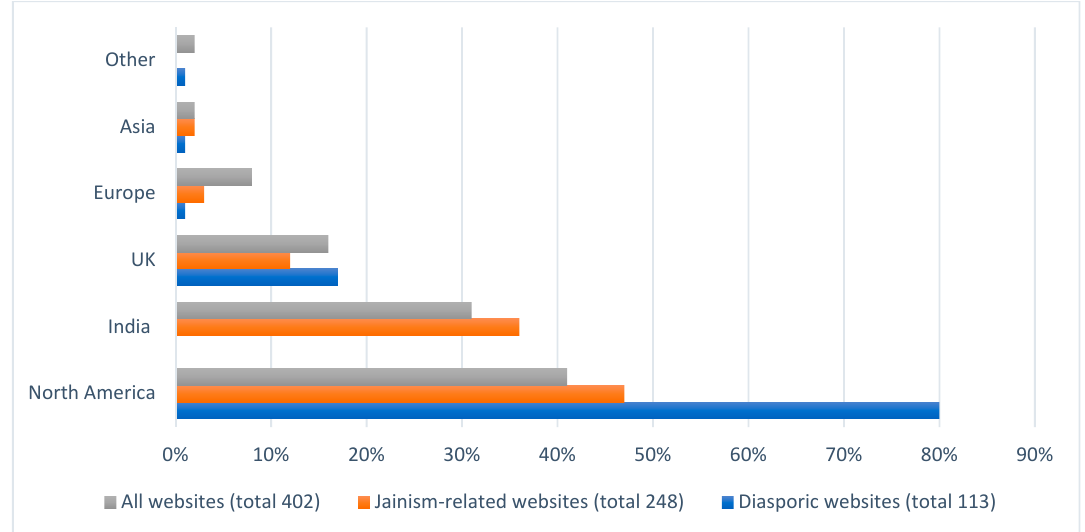
Figure 1. Geographic distribution of the 2017 website corpus.